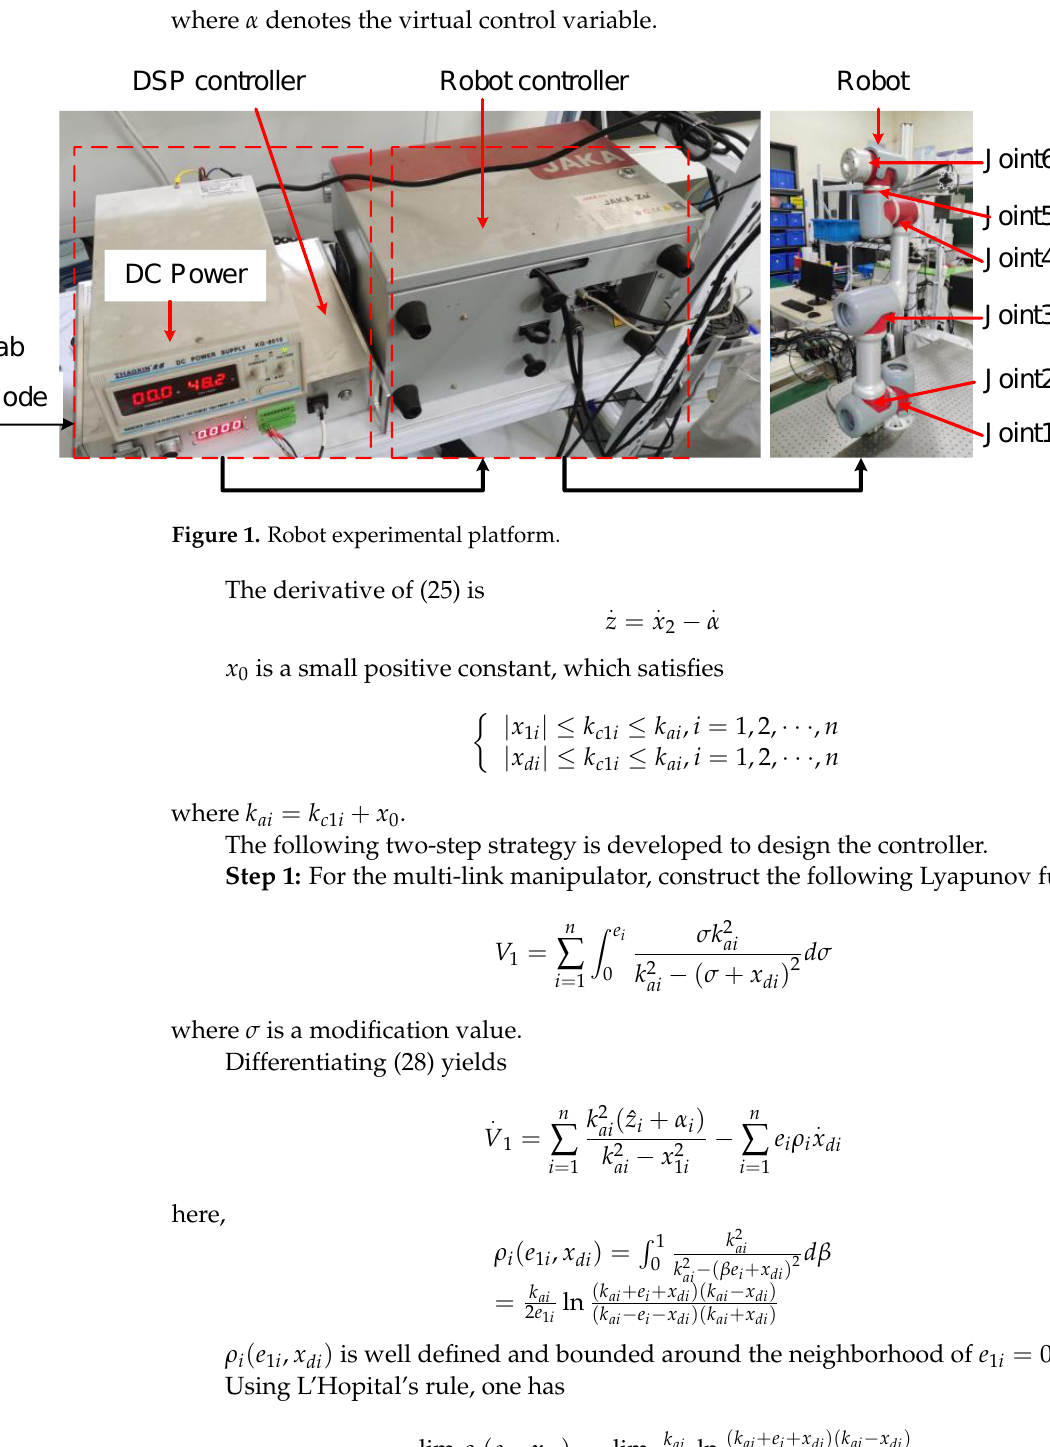
Table 1. Parameters of 2-DOF robot.